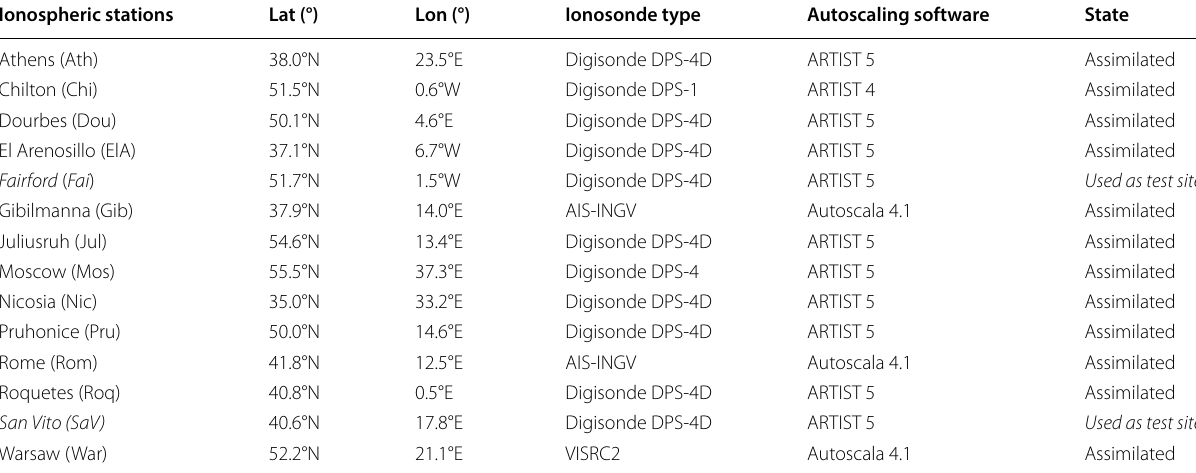
List of ionospheric stations considered in the study and their geographical coordinates. The ionosonde type, the autoscaling software, and the state of the station are also highlighted. In italics the stations used as test site Table 2 Ionosonde stations temporal availability Year Number of available ionospheric stations Available ionospheric stations for for assimilation